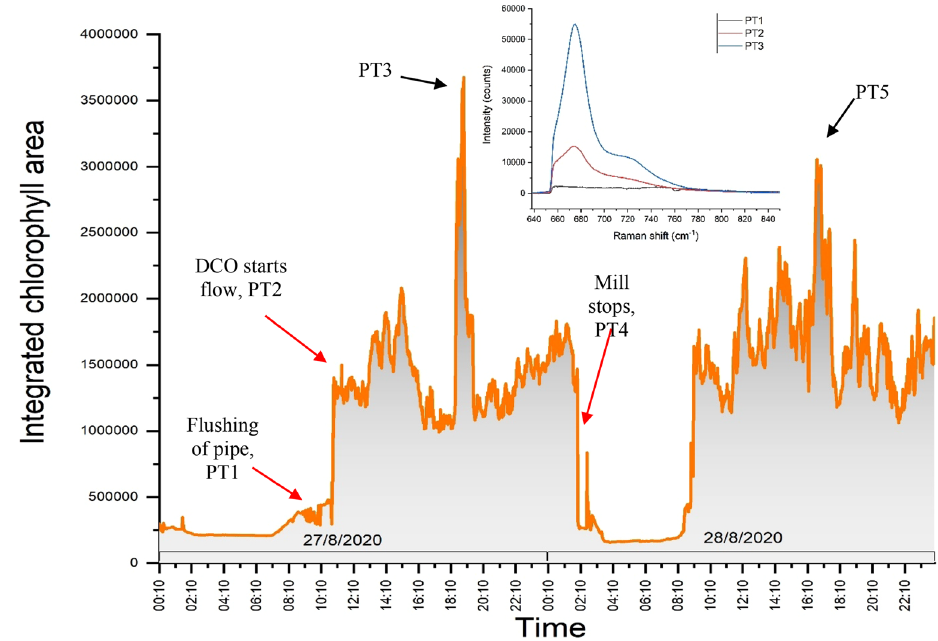
Figure 6. LICF operational plot for 2 days of mill run. PT1, PT2 and PT4 indicate the point in time of hot water pipeline flushing, DCO flows and end of mill operation, respectively. PT3 highlights the point when high chlorophyll level is being observed. Inset graph plots out the chlorophyll fluorescence at PT1, PT2 and PT3.